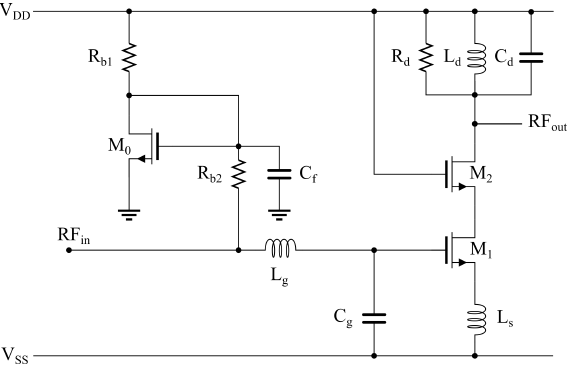
Figure 6. The inductively degenerated LNA considered in this